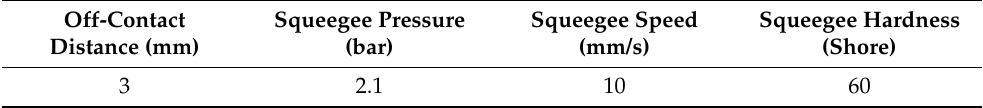
Table 3. Printing parameters derived from the experimental design.